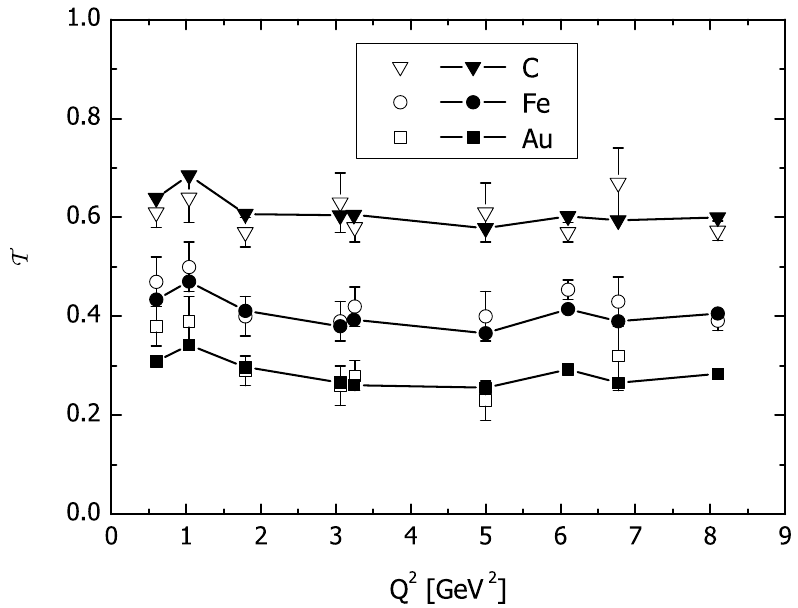
Figure 5. Transparency ratios for C, Fe and Pb targets as a function of Q 2 . The black, solid symbols show GiBUU results, while the open symbols provide data from JLAB and SLAC. Taken from [35], where also the references to the data can be